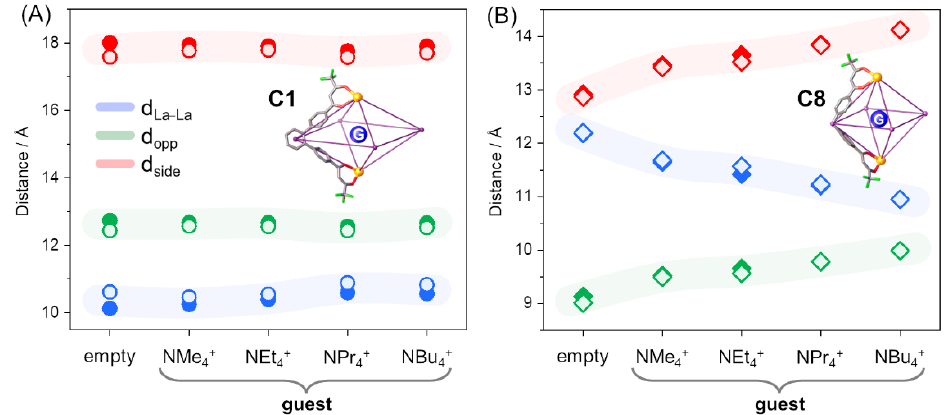
Figure 7. Distance variations (solvent calculations) of the C1 ( A ) and C8 ( B ) cages depending on guest presence and size for the helicate (filled symbols) and mesocate (hollow symbols) isomers. Distances are in Å.